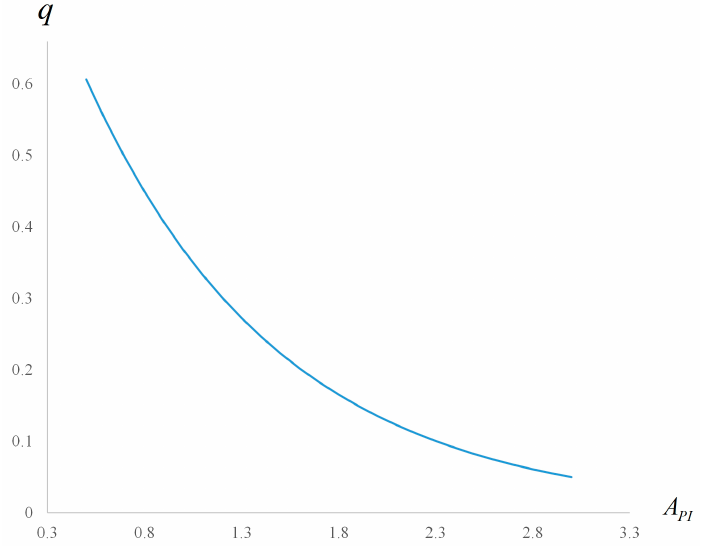
A and their corresponding values of q. Figure 1. Various values of performance index A PI and their corresponding values of q PI